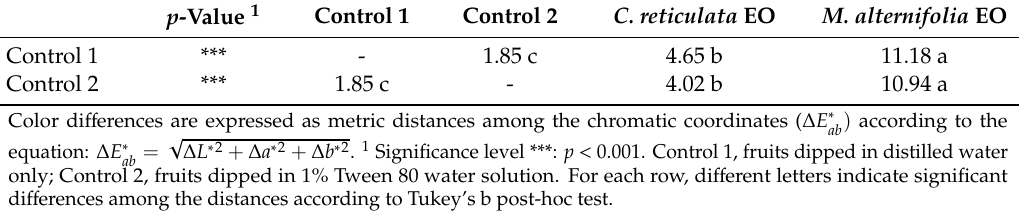
Table 4. Color di ff erence among cherries treated with EOs ( Citrus reticulata and Melaleuca alternifolia ) and the controls.